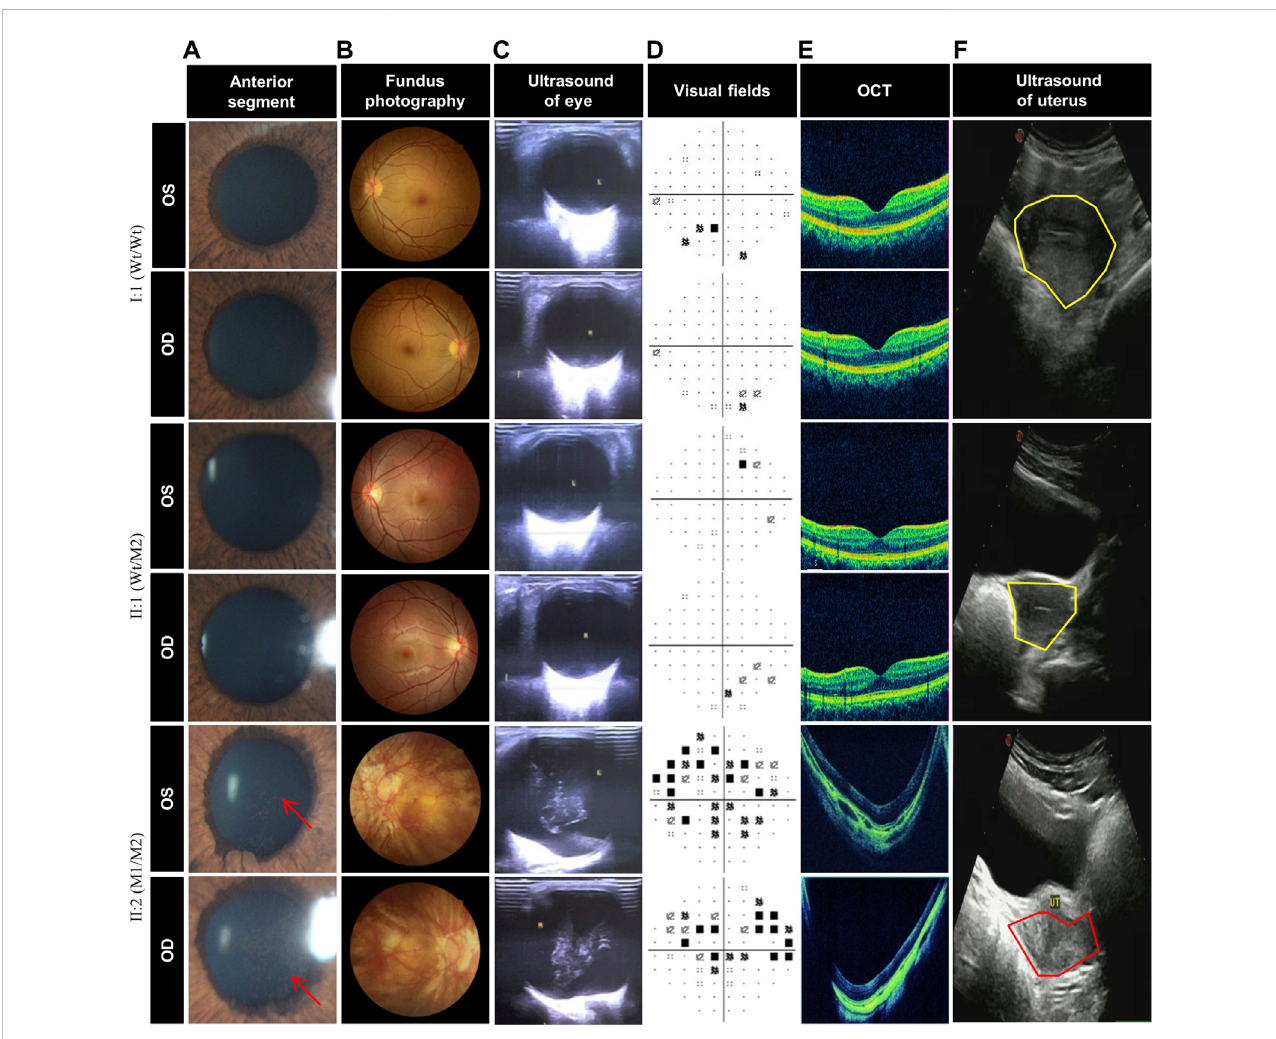
FIGURE 3 ClinicalphotographofDBSpatientwithearly-onsethighmyopiapatientandunaffectedmembers. (A) AnteriorsegmentphotographyoftheindividualsI: 2,II:1,andII:2,showingpersistentpupillarymembrane(redarrow)inII:2butnormalanteriorsegmentinI:1andII:1. (B) Fundusphotographyshowsseverehigh myopic retinopathy in II:2 but no change in I:1 and II:1. (C) Ocular color duplex ultrasonography of the individuals I:2, II:1, and II:2, showing bilateral posterior staphylomata and vitreous opacities in both eyes of II:2 while no change in I:1 and II:1. (D) Visual fi eld of II:2 shows small central scotoma and multiple paracentralscotomainbotheyes,butonlyverysmallparacentralscotomaweredetectedinbotheyesofI:2andII:1. (E) Opticalcoherencetomographyofthe individualsI:2,II:1,andII:2,showingfoveamaculadisappearedinII:2butnormalfoveamaculainI:1andII:1. (F) UterinecolorultrasoundoftheindividualsI:2,II: 1,and II:2,showingdicornal uterus(redcoil)in II:2,but theuteruses (yellow coil) ofI:1 and II:1are normal, andtheuterusofII:1is larger than that ofI:2 and